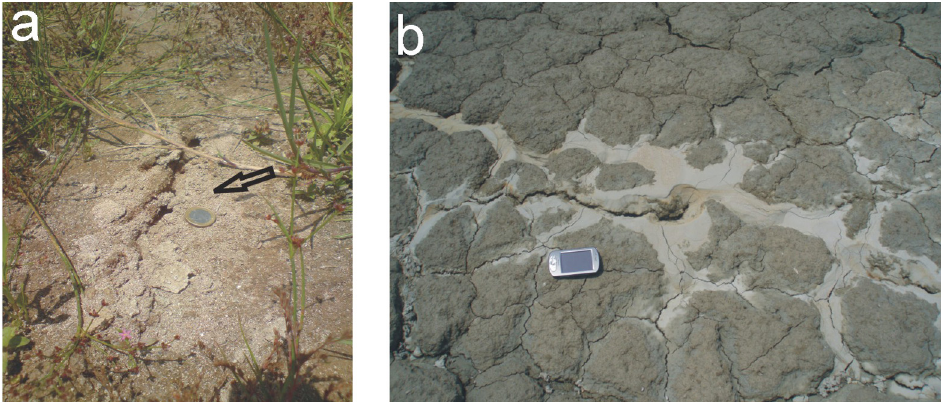
Figure 5. ( a) Ejection of sand-water mixture at the banks of Pinios River; (b) ejection of sand-water mixture at the shore of Pinios Lake (site